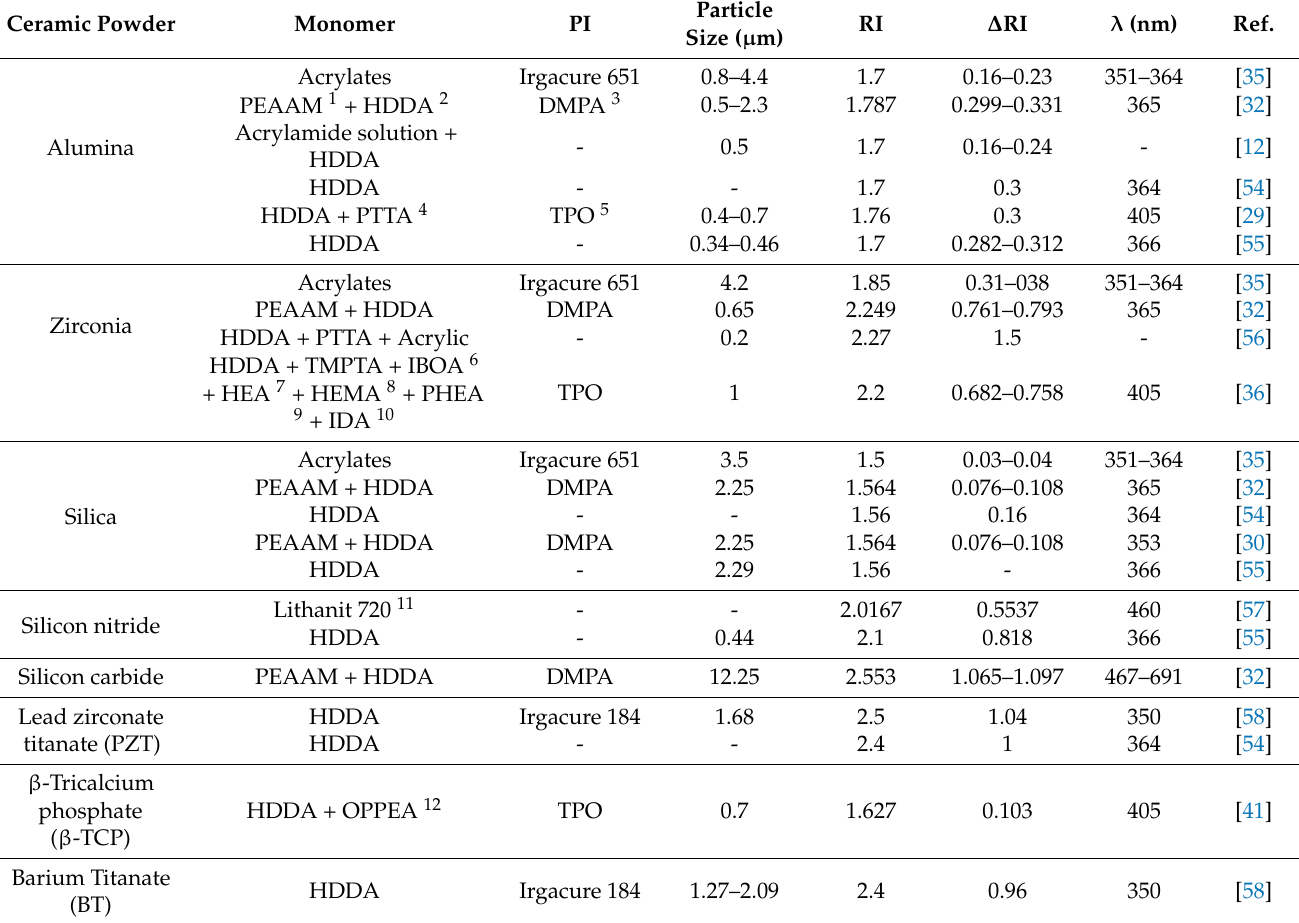
Table 1. Refractive Index of most commons ceramic powders used for stereolithography. λ is the wavelength of the irradiation.